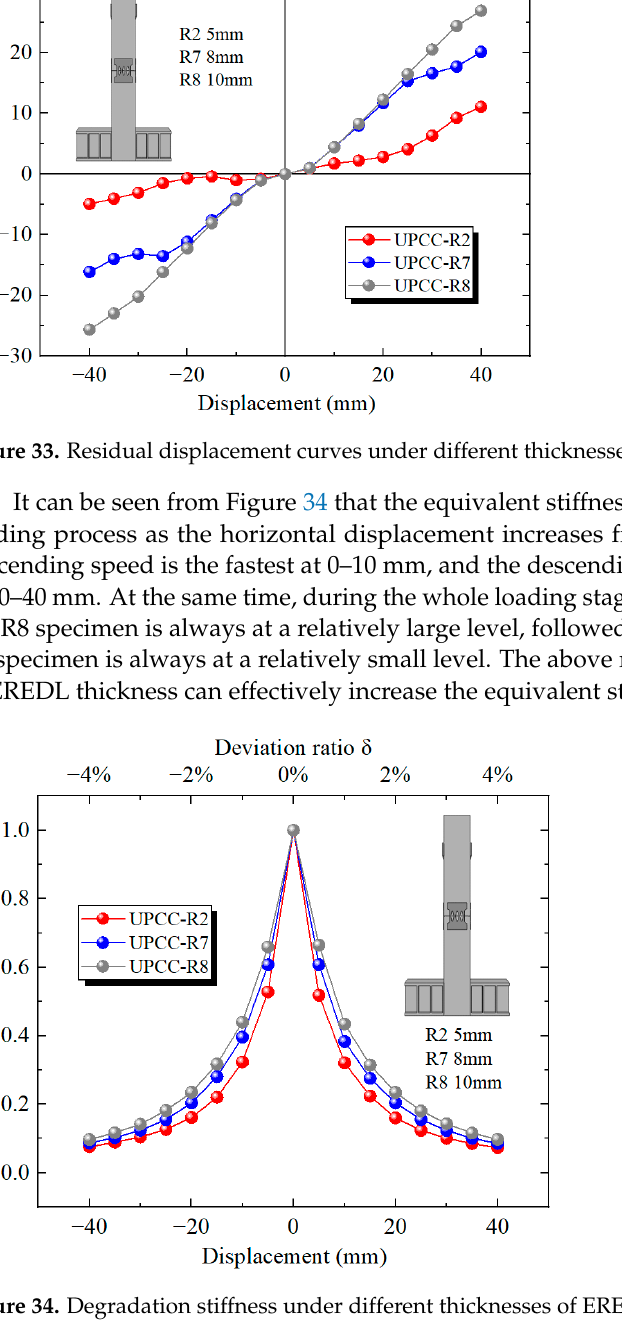
Figure 32. Equivalent viscous damping ratio under different thicknesses of EREDL.